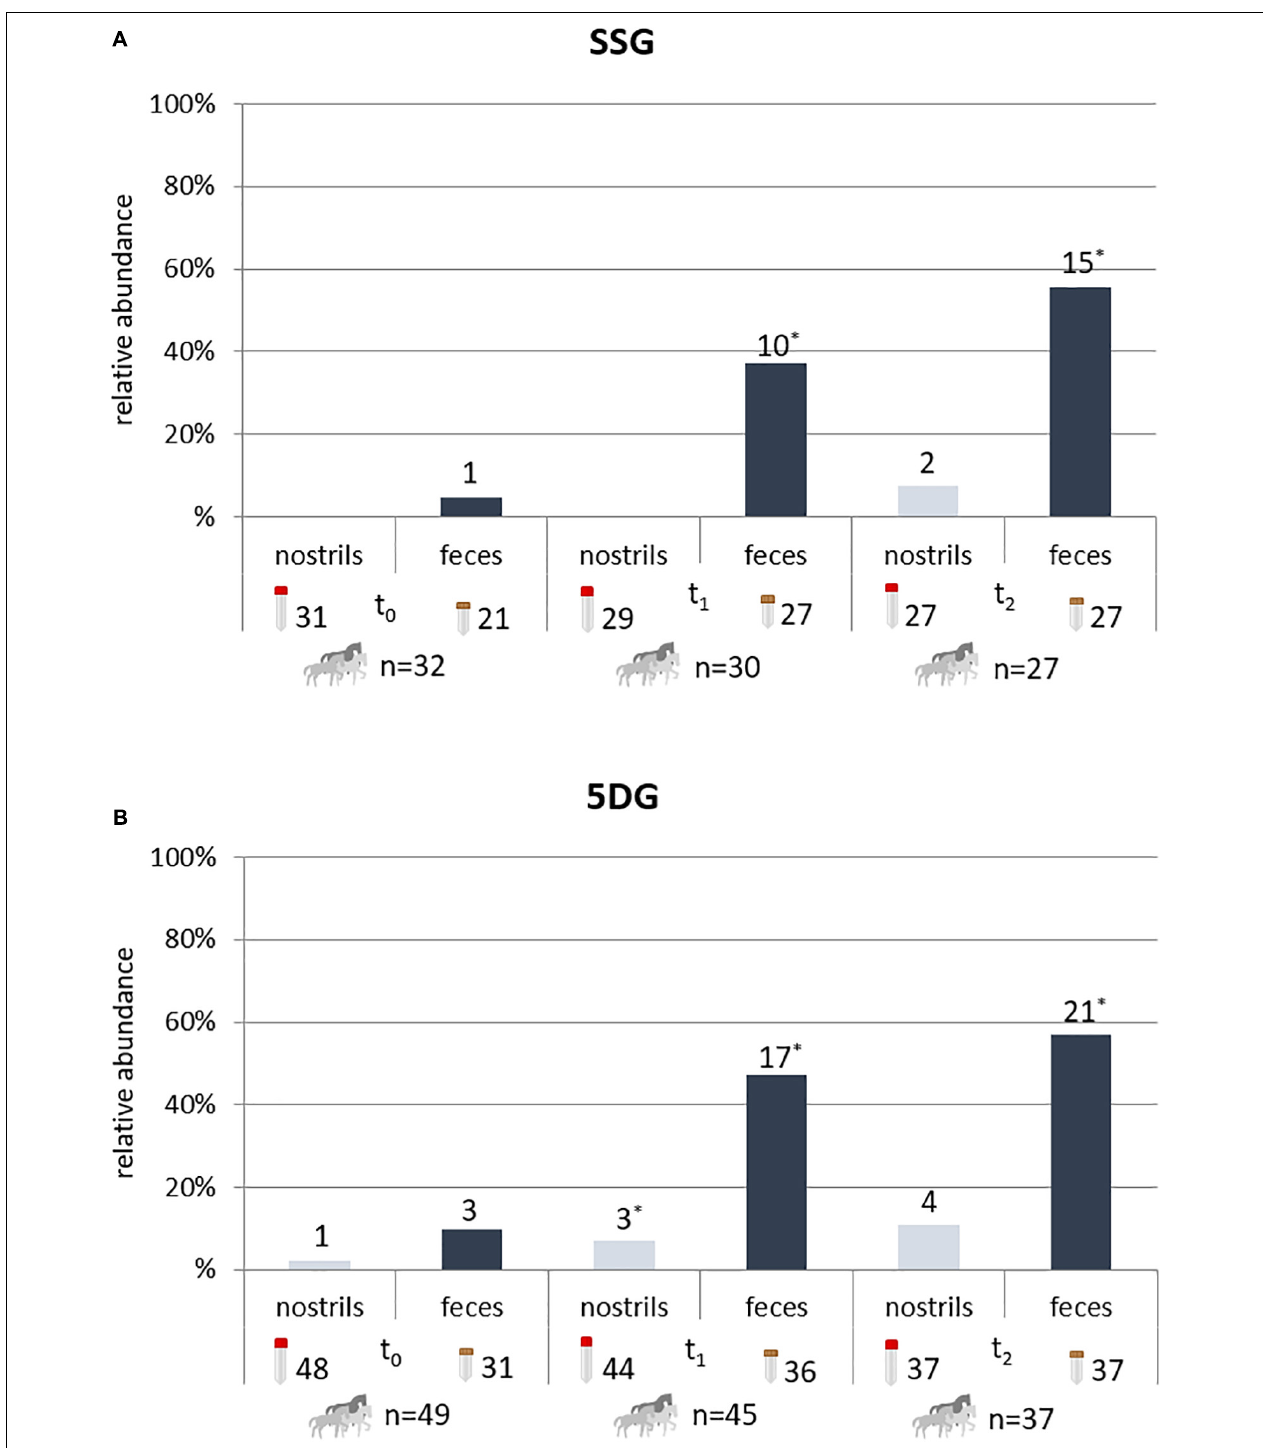
FIGURE 2 | Horses with ESBL-EC-positive specimens during hospital stay. Horses with ESBL-EC-positive specimens (nostril swabs and fecal samples) at t 0 (hospital admission), t 1 (3 days after surgery) and t 2 (10 days after surgery). Since defecation disorders are frequently associated with colic syndrome, fecal samples were not available for all horses at every time point. For the single-shot group (SSG), 32 horses met the criteria for participation in this study at t 0 (A) , with 31 nostril swabs and 21 fecal available for the screening procedure. Of the 49 horses initially allotted to the 5-day group (5DG), 48 nostril swabs and 31 fecal samples were collected at t 0 (B) . Due to the strict study design, specimens of horses failing the inclusion criteria in the ongoing study were excluded from further consideration at t 1 and/or t 2 , resulting in 27 participating horses for the SSG and 37 for the 5DG at t 2 . *, more than one isolate/specimen possible.